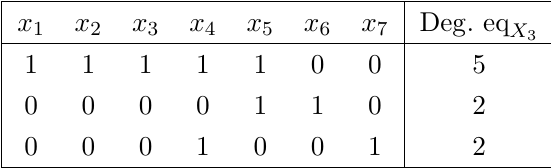
Table 4 . Scalings of the coordinates for the Q dP 7 space together with the multidegree of the equation cutting the double cover Calabi-Yau threefold X 3